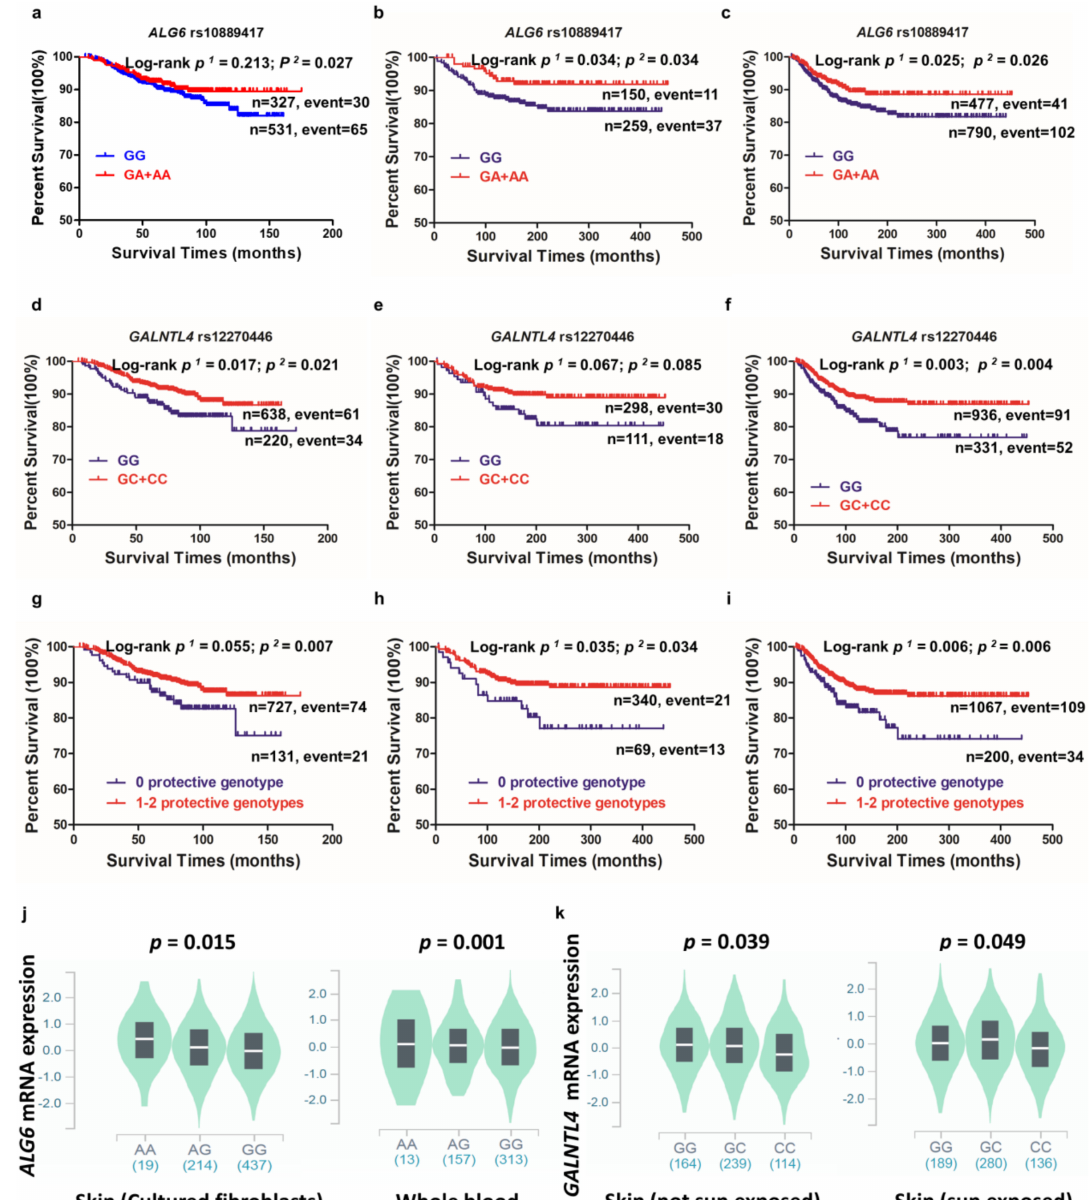
Figure 2. Association of two independent SNPs in glycosylation-related pathway genes with CMSS and their genotypes. Assuming the dominant model was used in the ( a ) MDACC, ( b ) NHS / HPFS, and ( c ) MDACC and NHS / HPFS combined dataset, the Kaplan–Meier survival curve of CMSS with ALG6 rs10889417 stratification. Assuming the dominant model was used in ( d ) MDACC, ( e ) NHS / HPFS, and ( f ) the MDACC and NHS / HPFS combined dataset, the Kaplan–Meier survival curve of CMSS with GALNTL4 rs12270446 stratification. The combined risk genotypes on CMSS (Kaplan–Meier survival curves): the dichotomized 0 NPG (Number of Protective Genotype) group and 1-2 NPG group in ( g ) MDACC, ( h ) NHS / HPFS, and ( i ) the MDACC and NHS / HPFS combined dataset. ( j ) The correlation between ALG6 rs10889417 genotypes with its mRNA expression levels in both cultured skin fibroblasts and whole blood cells from the GTEx (Genotype-Tissue Expression) database. ( k ) The correlations of GALNTL4 rs12270446 genotypes with its mRNA expression levels in skin tissues from the GTEx